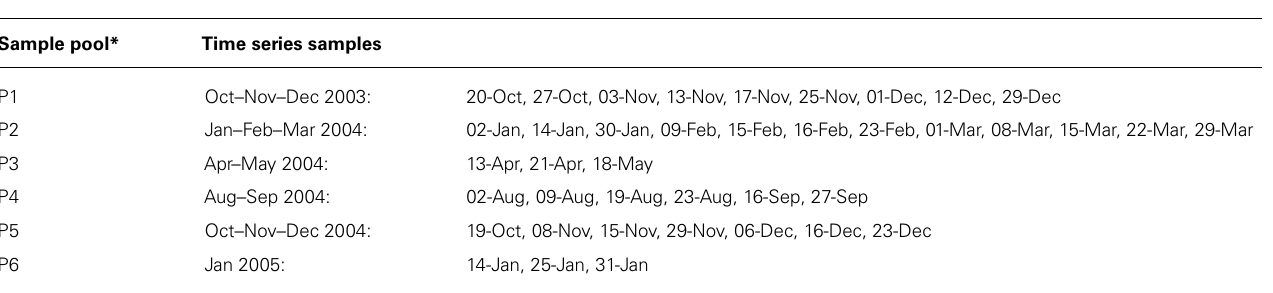
Table 2 | North Sea time series high molecular weight DNA samples. Sample